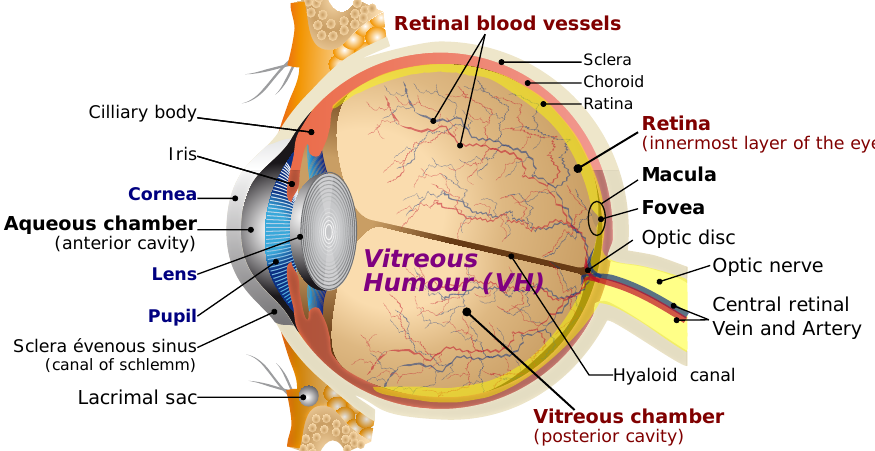
Figure 1. Schematic representation of the human eye.